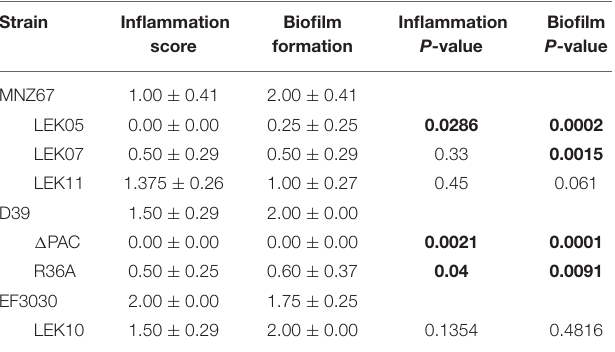
TABLE 2 | Inflammation and biofilm scores of infected chinchillas. Strain Inflammation